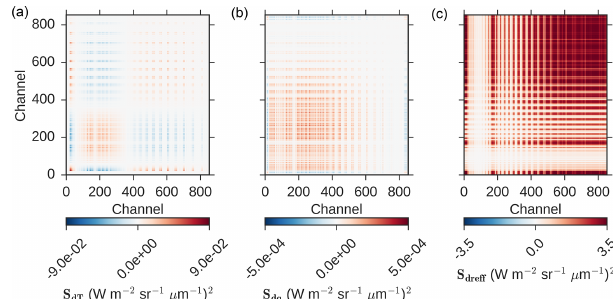
Figure 2. Example covariance matrices for each component as la- belled in the colour bar: (a) temperature, (b) humidity, and (c) ef- fective radius.